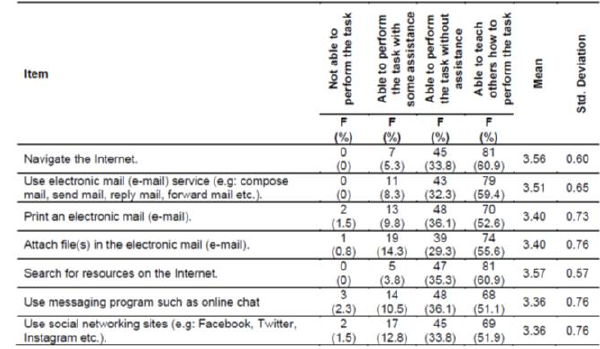
Table 9. Descriptive Statistics for Items